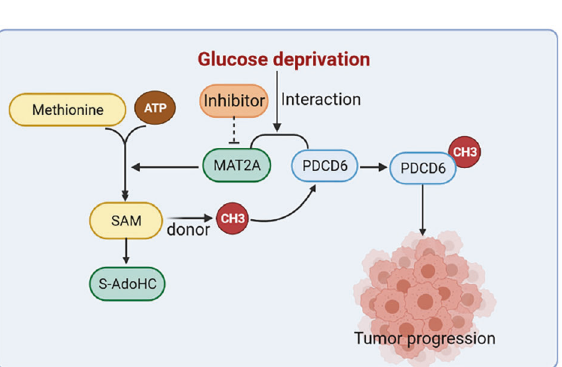
Fig. 6 The schematic model showing the interaction between MAT2A and PDCD6 under glucose deprivation in cervical cancer cells. MAT2A facilitates PDCD6 methylation to promote cervical cancer growth under glucose